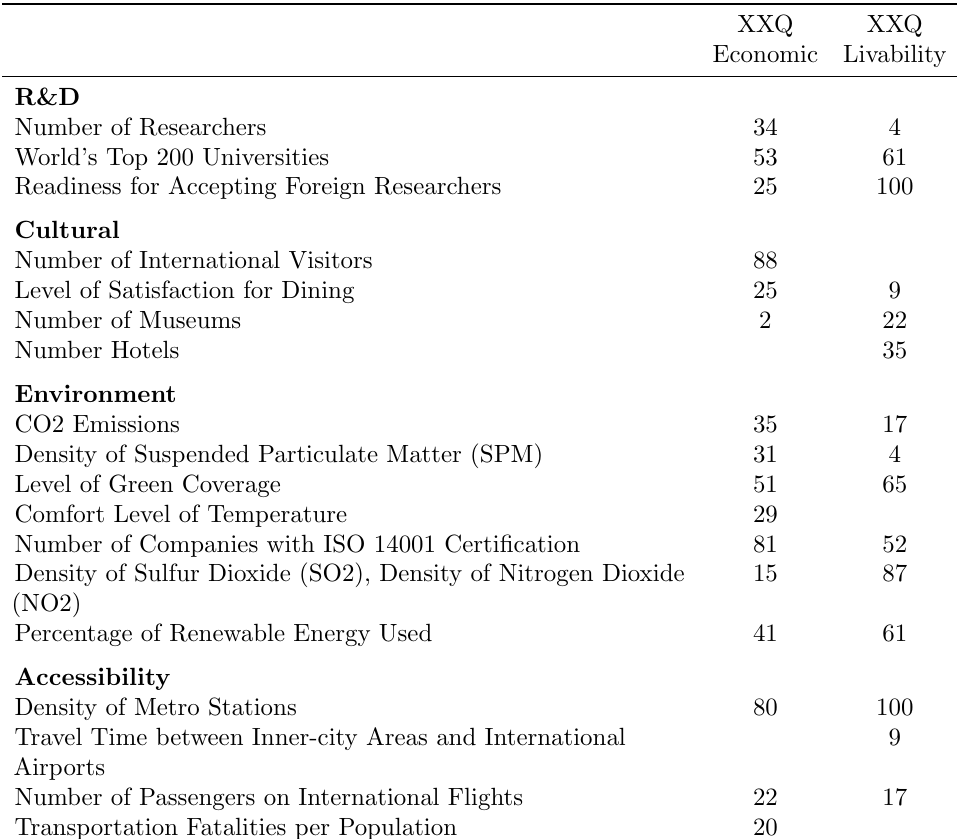
Table 6: The most important single sub-factors